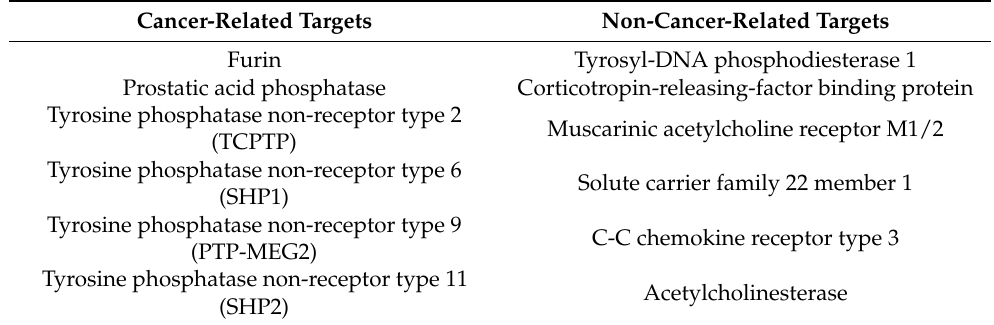
Table 4. Classification of the putative protein targets of the cytotoxic hit compounds ( 2b , 2d , 2e ).